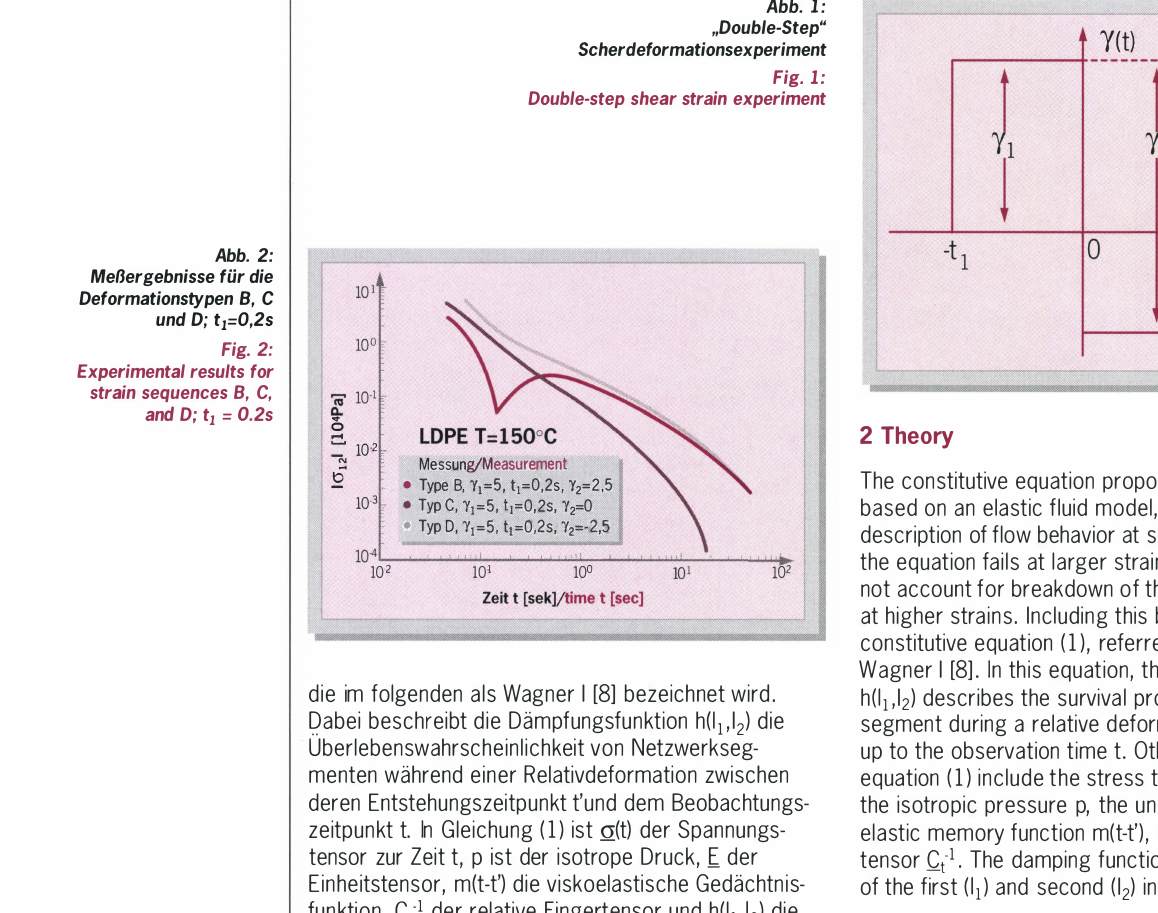
Abb. 2: Meflergebnisse fiir die